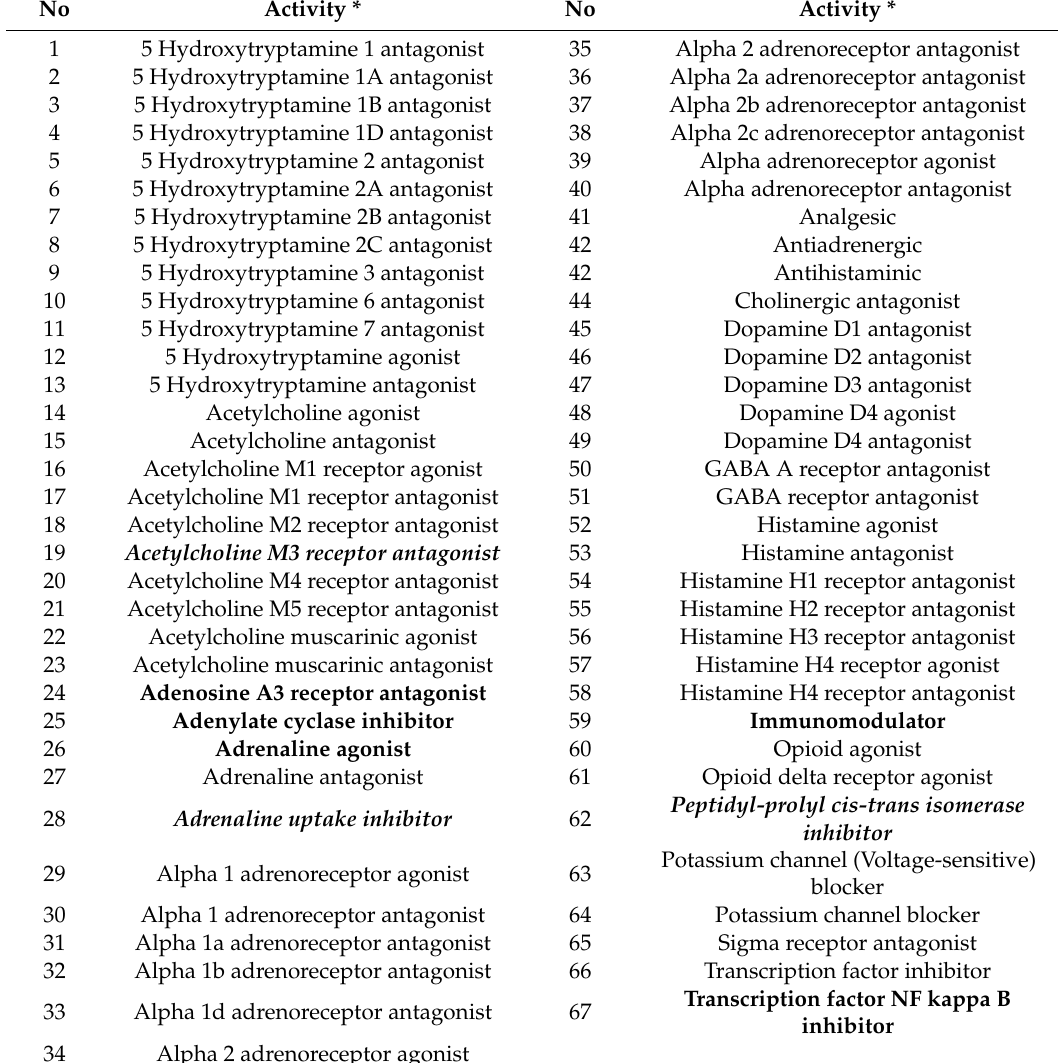
Table 2. Clozapine’s mechanisms of action according to the PASS training